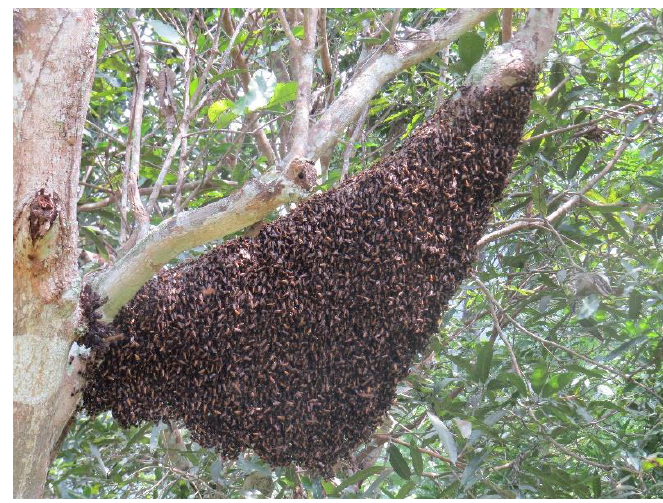
Figure 1. A large bivouac of giant honey bees, still agitated from its arrival flight, settles on a mango branch at the study site. Photo: Willard S.